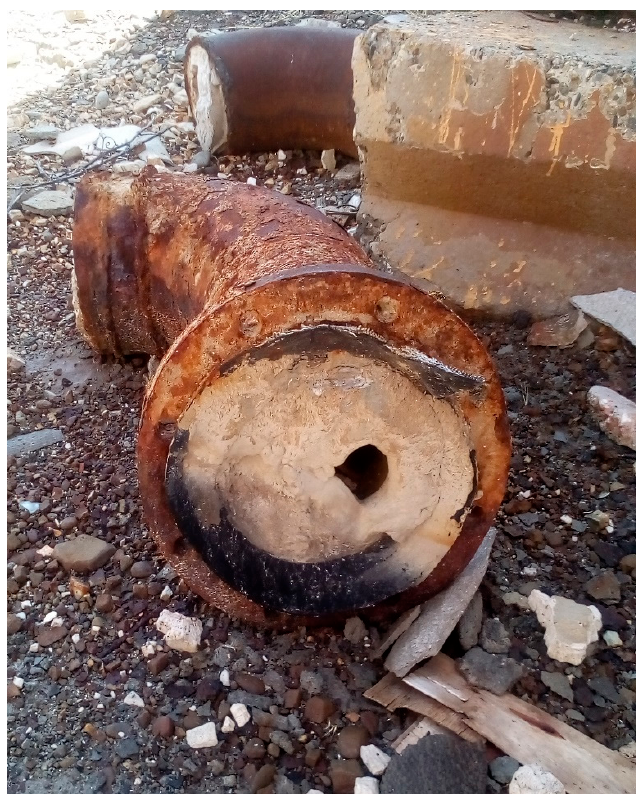
Figure 20. The appearance of a pipe in a geothermal heating system without an acoustic–magnetic device.